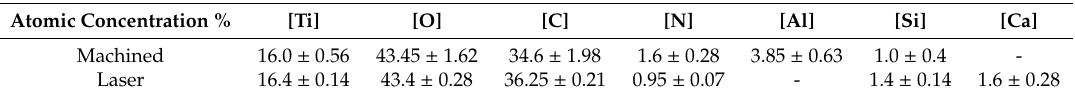
Table 1. Atomic concentration of the elements detected on the machined and lasered implant surfaces from the X-Ray Photoelectron Spectroscopy (XPS)